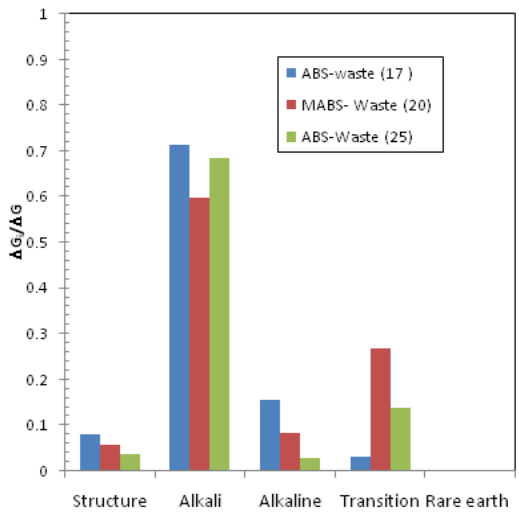
Figure 5. Contribution of the waste matrix constituents to the hydration free energy.